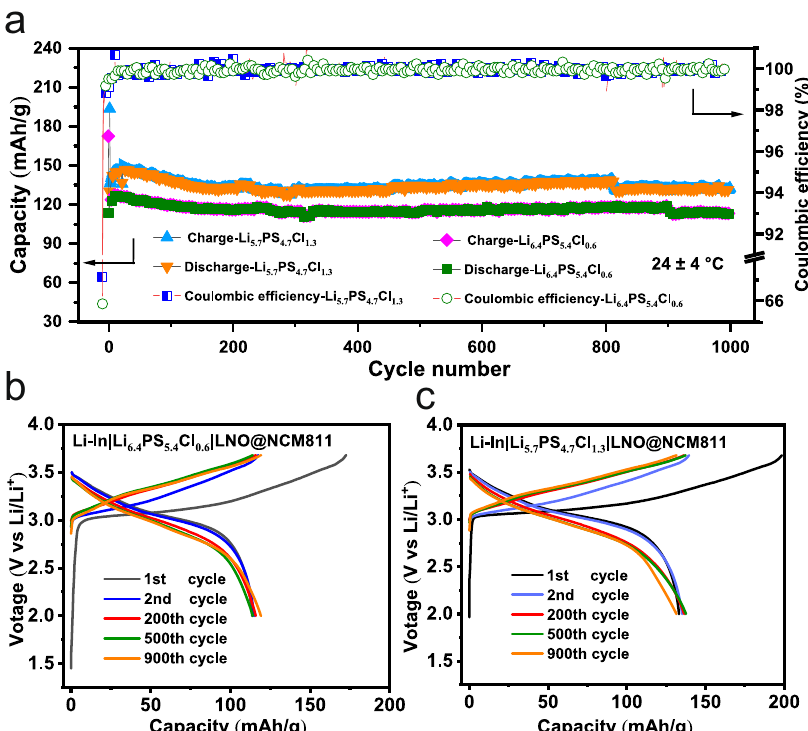
Fig. 7 Electrochemical cycling performance of Li-In||LNO@NCM811 cells. a Capacity and Coulombic ef fi ciency for 1000 cycles run at 0.5 mA/cm 2 at 24 ± 4 °C using Cl-06 and Cl-13 SEs. Charge/discharge pro fi les for Cl-06 ( b ) and Cl-13 ( c )